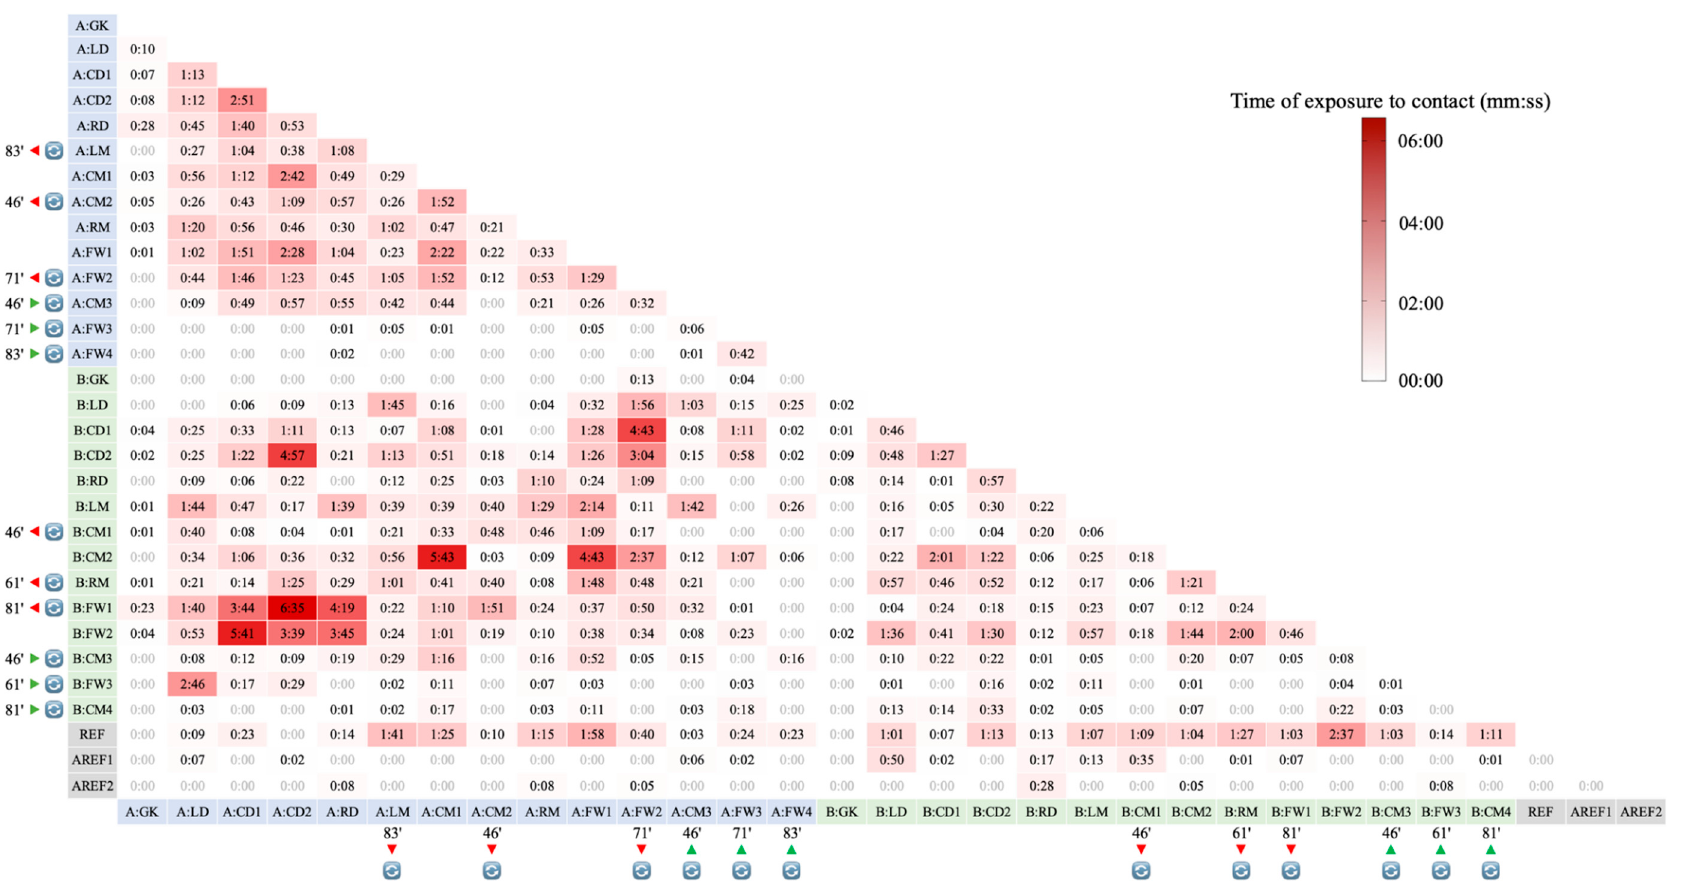
Figure 3. Accumulated time (mm:ss) each individual was positioned for less than 2 m from other individuals (players and referees). Blue cells represent players from team A, green from team B, and grey the referees. The symbol depicts the players that were substituted and the match time of occurrence. GK = Goalkeeper, LD = Left Defender, CD = Central Defender, RD = Right Defender, LM = Left Midfielder, CM = Central Midfielder, RM = Right Midfielder, FW = Forward, REF = Referee, AREF = Assistant Referee.